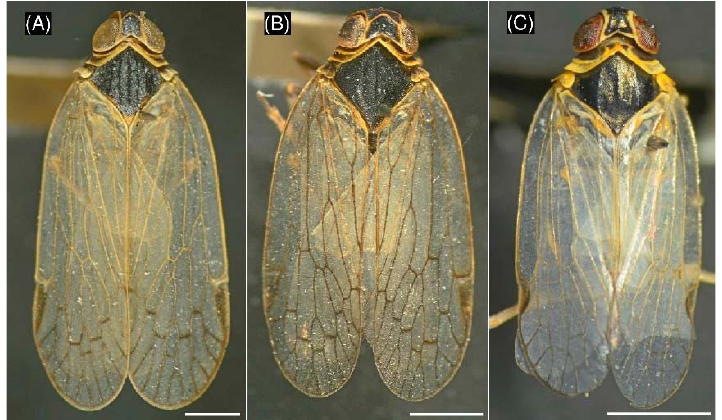
Figure 1. Morphology of three close cixiid planthoppers showing hyaline or transparent wings, the fore wings are characterised by a roof-shaped resting position, and the mesonotum has five keels. ( A ) Pentastiridius leporinus , ( B ) Reptalus quinquecostatus , ( C ) Hyalesthes obsoletus . Scale bar represents 1 mm.